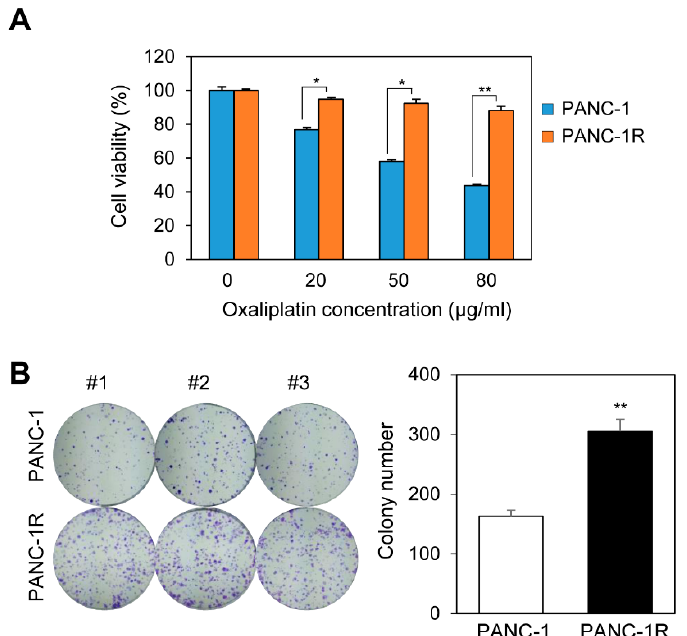
Figure 1. Establishment of oxaliplatin-resistant pancreatic cancer cell line. ( A ) Cellular viability was assayed by Ez-cytox on PANC-1 and PANC-1R with oxaliplatin for 2 days. ( B ) The colony formation assays were performed on PANC-1 and PANC-1R, respectively. * p < 0.05, ** p < 0.01.